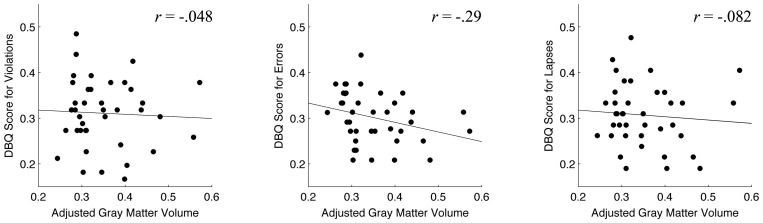
Scatter diagrams of Driving Behavior Questionnaire (DBQ) scores and gray matter volume at the peak locus (MNI coordinates: x = −3, y = 1, z = 70; BA 6, supplementary motor area) found in VBM analysis for executive function capacity.Panels A, B and C denote DBQ scores for violations, errors and lapses, respectively, during daily driving. Each dot represents each participant. No significant correlation was found (P>0.05/3; one-tailed Pearson's correlation test adjusted by the Bonferroni correction for multiple comparison).